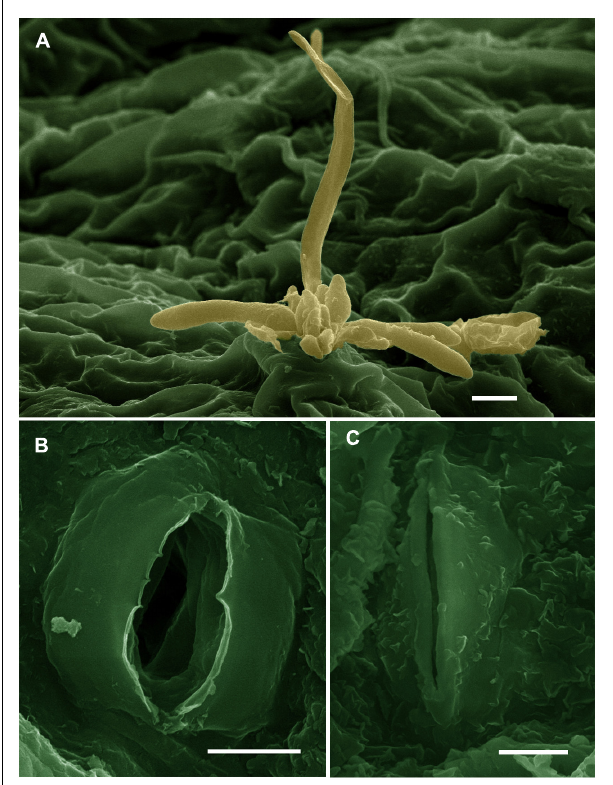
FIGURE 2 | Scanning electron micrographs showing (A) sporangiophores of Plasmopara viticola emerging from the stomatal pore on the abaxial surface of a grapevine leaf (bar = 10 µ m), (B) opened stomata in a leaf from the untreated control grapevine (bar = 5 µ m), and (C) closed stomata in a grapevine leaf treated with SiNPs at 150 ppm (bar = 5 µ m). These micrographs were colorized using the Adobe Photoshop CS6